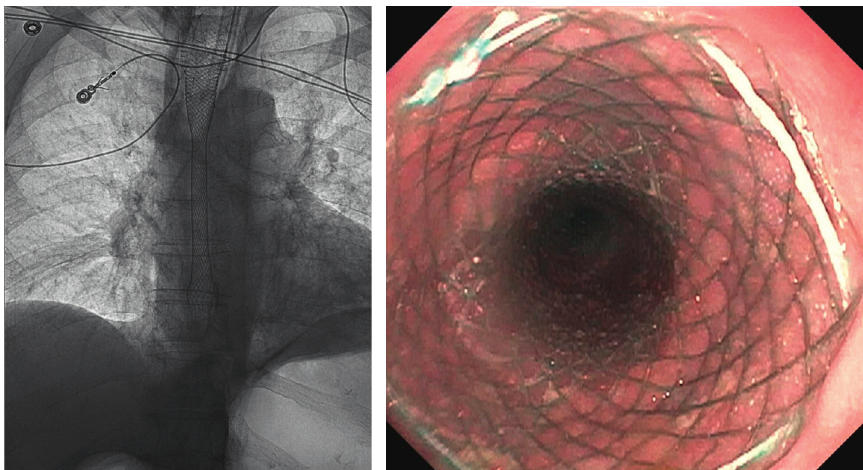
Figure 6: A fully covered esophageal metal stent placement under